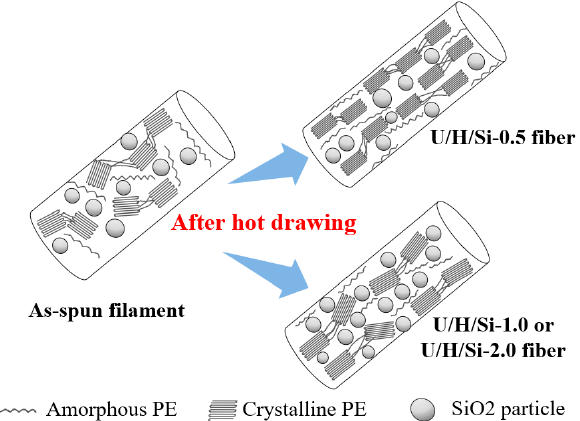
Figure 7. Possible mechanism of modified nano-SiO 2 in hot drawing stage.